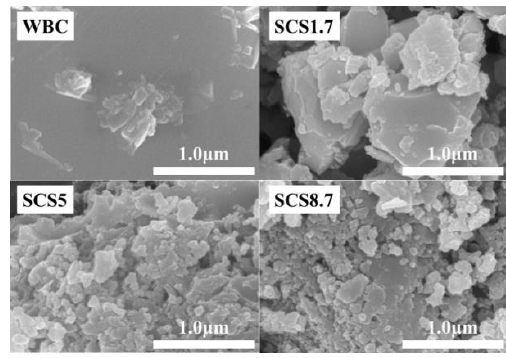
Figure 3. SEM images of the fresh glycine/Fe (SCS) and WBC catalyst.